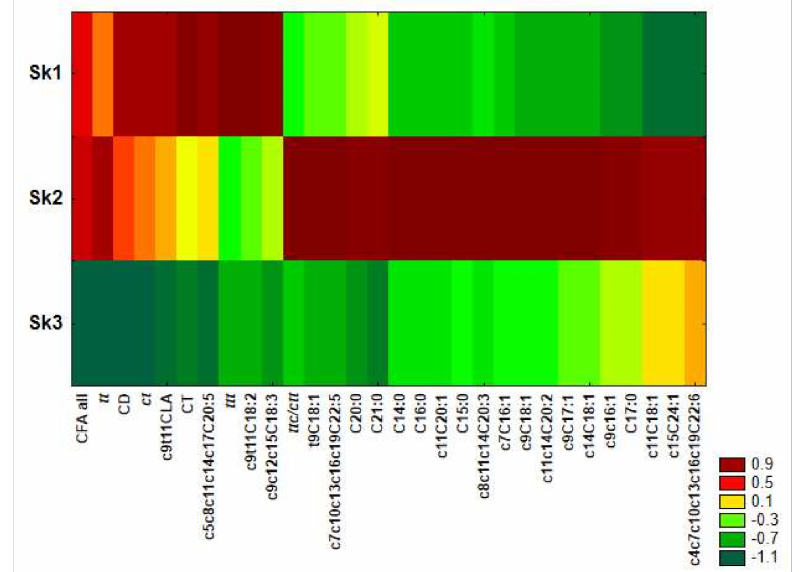
Figure 4. Heat maps of FA and CFA profiles in the microsomes of experimental